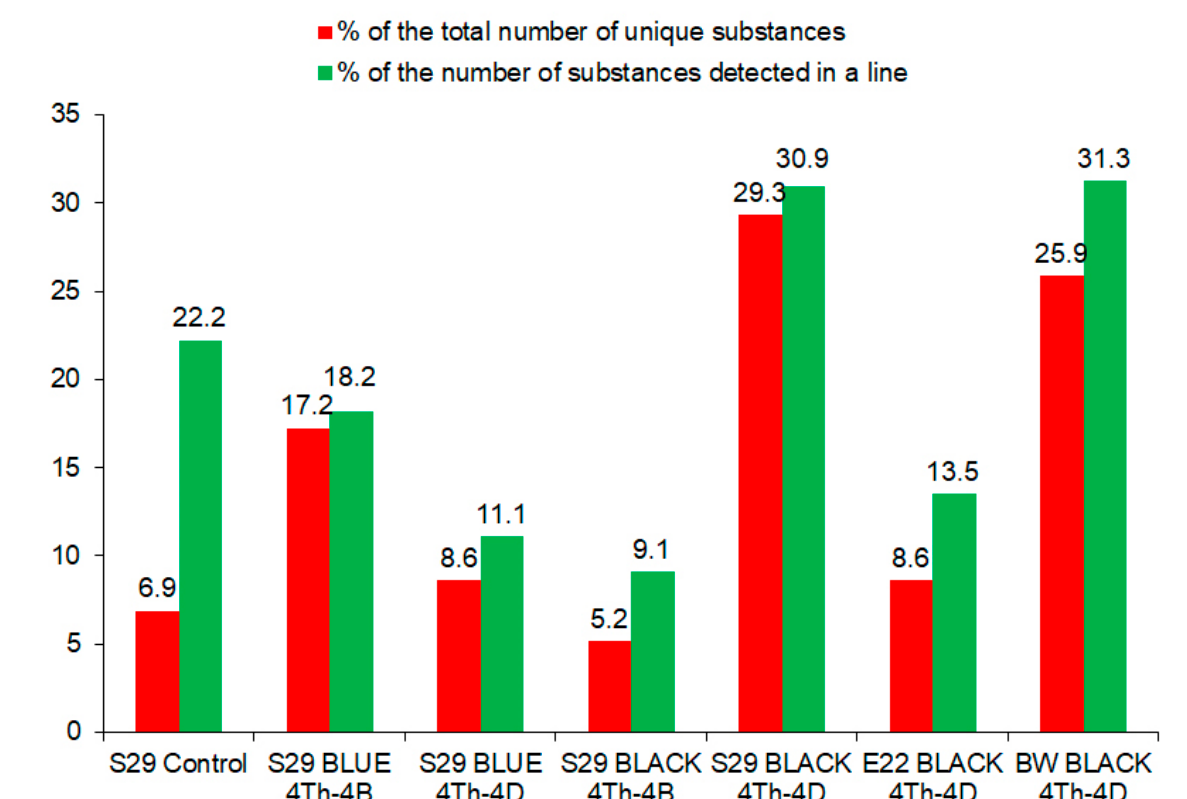
Figure 5. Assessment of the contributions of unique substances to the total pool of phenolic and nonphenolic compounds in the seven lines of T. aestivum .